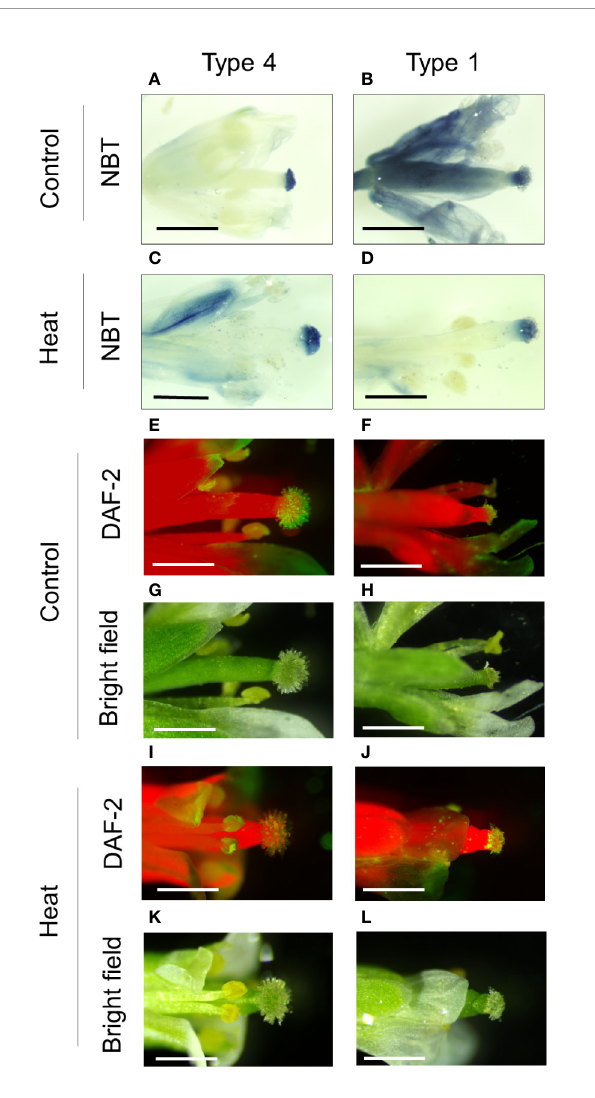
FIGURE 6 | Distribution of O 2- and NO in reproductive organs of Arabidopsis thaliana grown under control conditions or subjected to heat stress. (A – D) NBT staining of reproductive organs in fl owers with rich (type 1) or poor (type 4) pollination under control (A, B) or heat stressed (C, D) conditions. (E – L) DAF-2 staining of reproductive organs in fl owers with rich (type 1) or poor (type 4) pollination under control (E, F) and heat stressed (I, J) conditions. (G, H, K, L) Bright fi eld images. Bars indicate